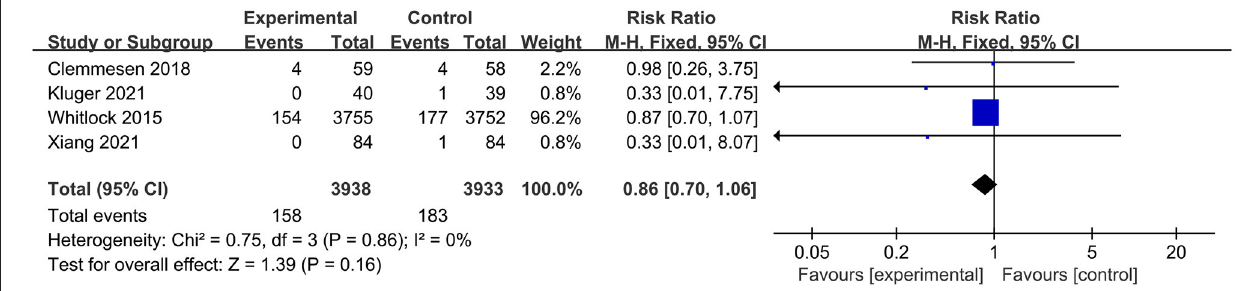
FIGURE 12 | Forest plot of postoperative 30-day mortality.